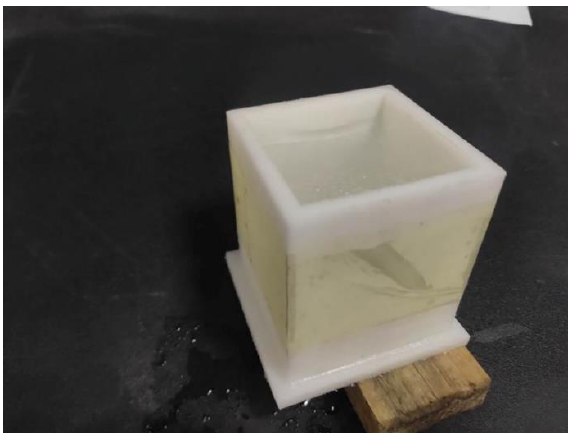
Figure 9. The 3D resin printing mold for the shear strength test.